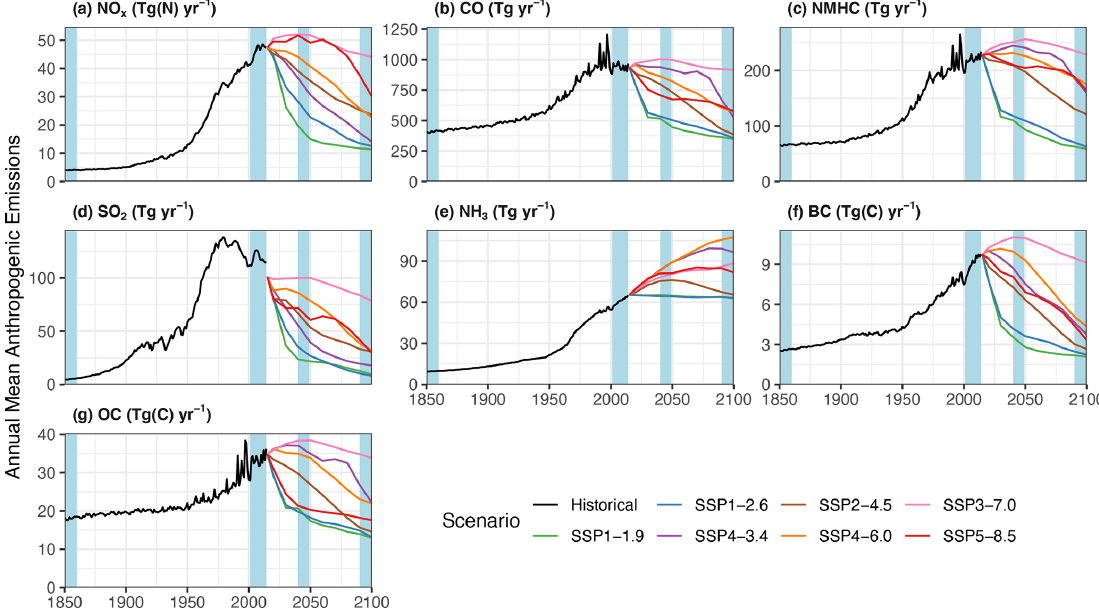
Figure 6. Time series of annual mean CMIP6 anthropogenic emissions for 1850–2100CE for (a) reactive oxides of nitrogen (NO x ≡ NO + NO 2 ) in TgNyr − 1 , (b) carbon monoxide (CO) in Tgyr − 1 , (c) non-methane hydrocarbons (NMHCs) in Tgyr − 1 , (d) sul- fur dioxide (SO 2 ) in Tgyr − 1 , (e) ammonia (NH 3 ) in Tgyr − 1 , (f) black carbon (BC) in TgCyr − 1 , and (g) organic carbon (OC) in TgCyr − 1 . Historical emissions for 1850–2014CE from Hoesly et al. (2018) are shown as black lines. Future scenarios for 2015–2100CE from Gid- den et al. (2019) are shown as colored lines: SSP1-1.9 (green); SSP1-2.6 (blue); SSP4-3.4 (purple); SSP2-4.5 (brown); SSP4-6.0 (orange); SSP3-7.0 (pink); SSP5-8.5 (red). The shaded blue rectangles indicate periods for which GCAP 2.0 input meteorology is available at the time of publication.